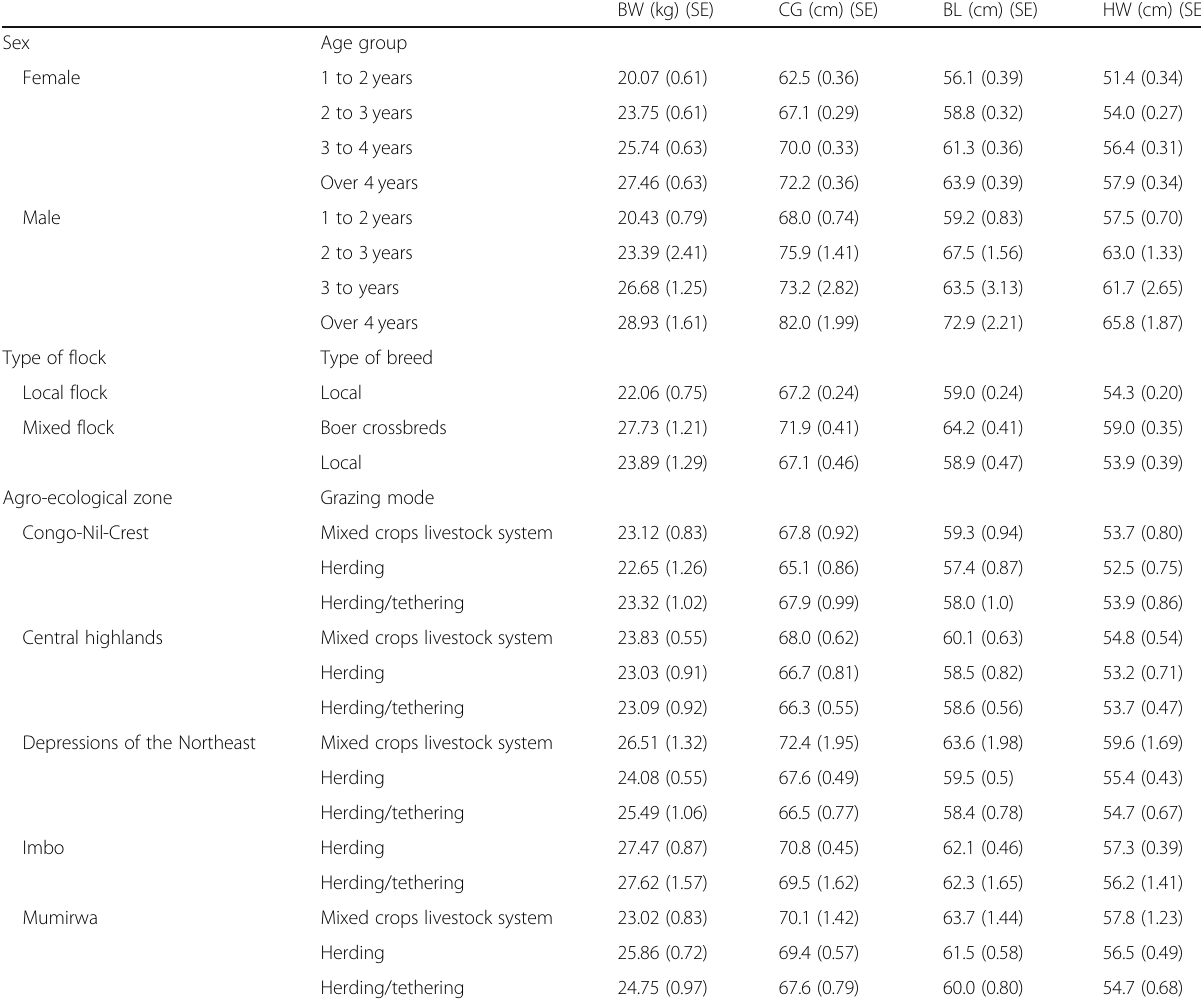
Table 3 Least-square means (LSM) and standard errors (SE) of body measurements per age group and sex, per genetic group and flock type, and per grazing mode and agro-ecological